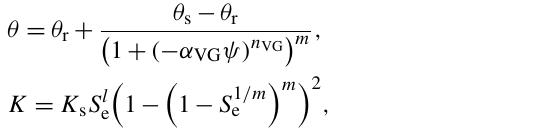
. (c) The loss term for the continuity of the neural network output L I q